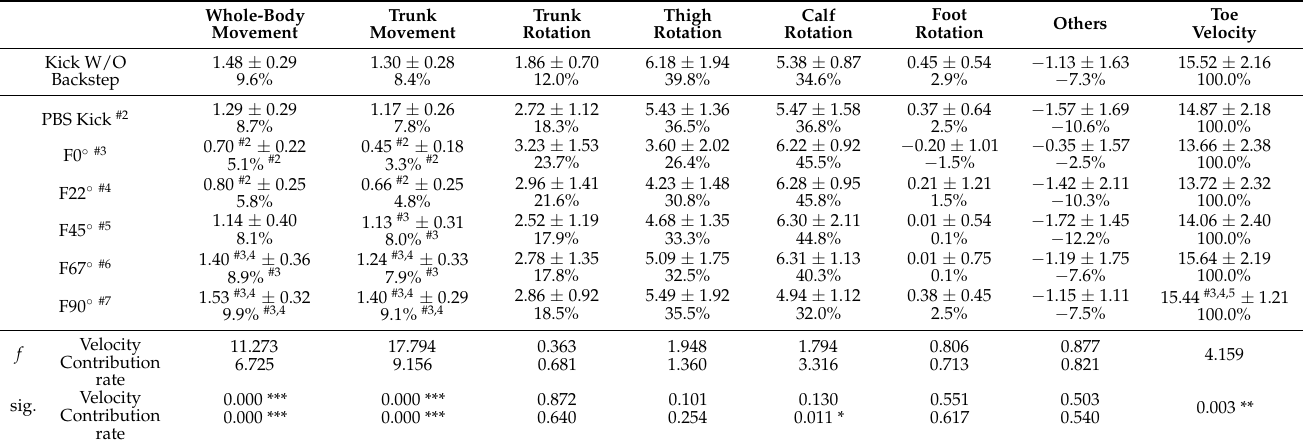
Table 3. The contributions of the roundhouse kick with angle-change types of footwork in impact event. Unit: